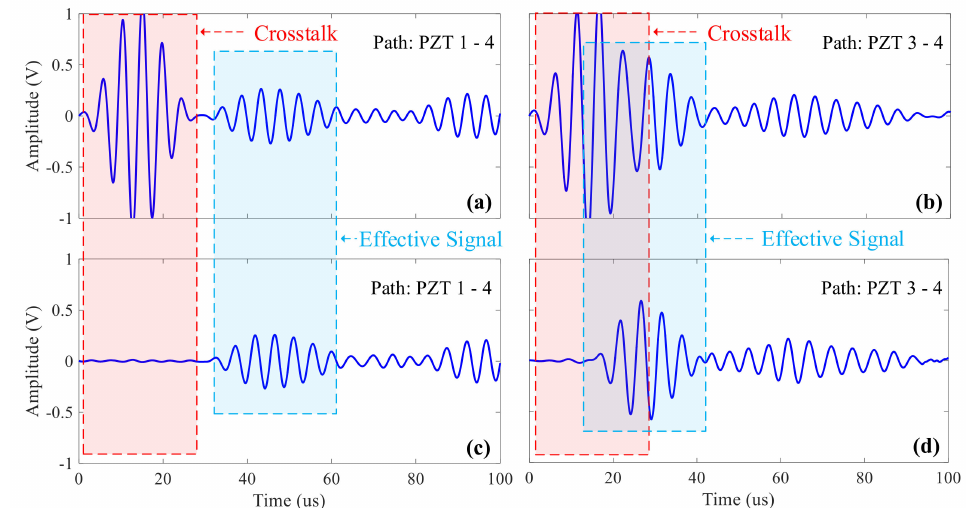
Figure 12. Comparison test of the crosstalk of di ff erent systems: ( a ) / ( b ) the waveform acquired by ScanGenie; ( c ) / ( d ) the waveform acquired by the proposed system in this